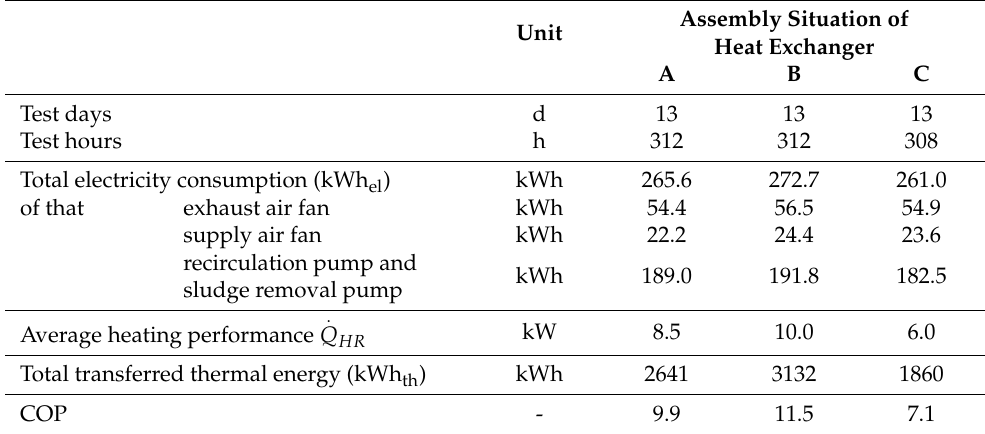
Table 1. Overview of the most important data for calculating the coefficient of performance (COP) for the three heat exchanger assembly situations